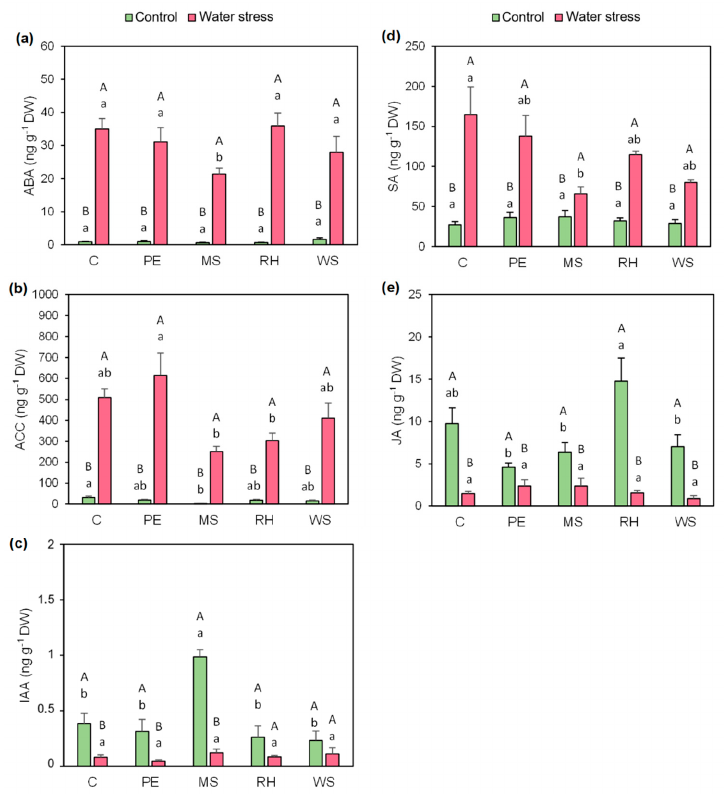
Figure 6. ( a ) Abscisic acid (ABA), ( b ) 1-aminocyclopropane-1-carboxylic acid (ACC), ( c ) indole acetic acid (IAA), ( d ) salicylic acid (SA), and ( e ) jasmonic acid (JA) concentrations in leaves of escarole plants of the commercial variety “Brillantes” non-mulched or subjected to different mulching treatments and cultivated under control (well-watered) and water stress (70% ETc) conditions. Bars show the means of five plants ± standard error. Different capital letters indicate significant differences due to the water stress treatment while different small letters show significant differences among mulching treatments according to Tukey’s test ( p ≤ 0.05). Abbreviations used: non-covered substrate (C), polyethylene mulch (PE), mushroom substrate-based hydromulch (MS), rice hulls-based hydromulch (RH), and wheat straw-based hydromulch (WS).